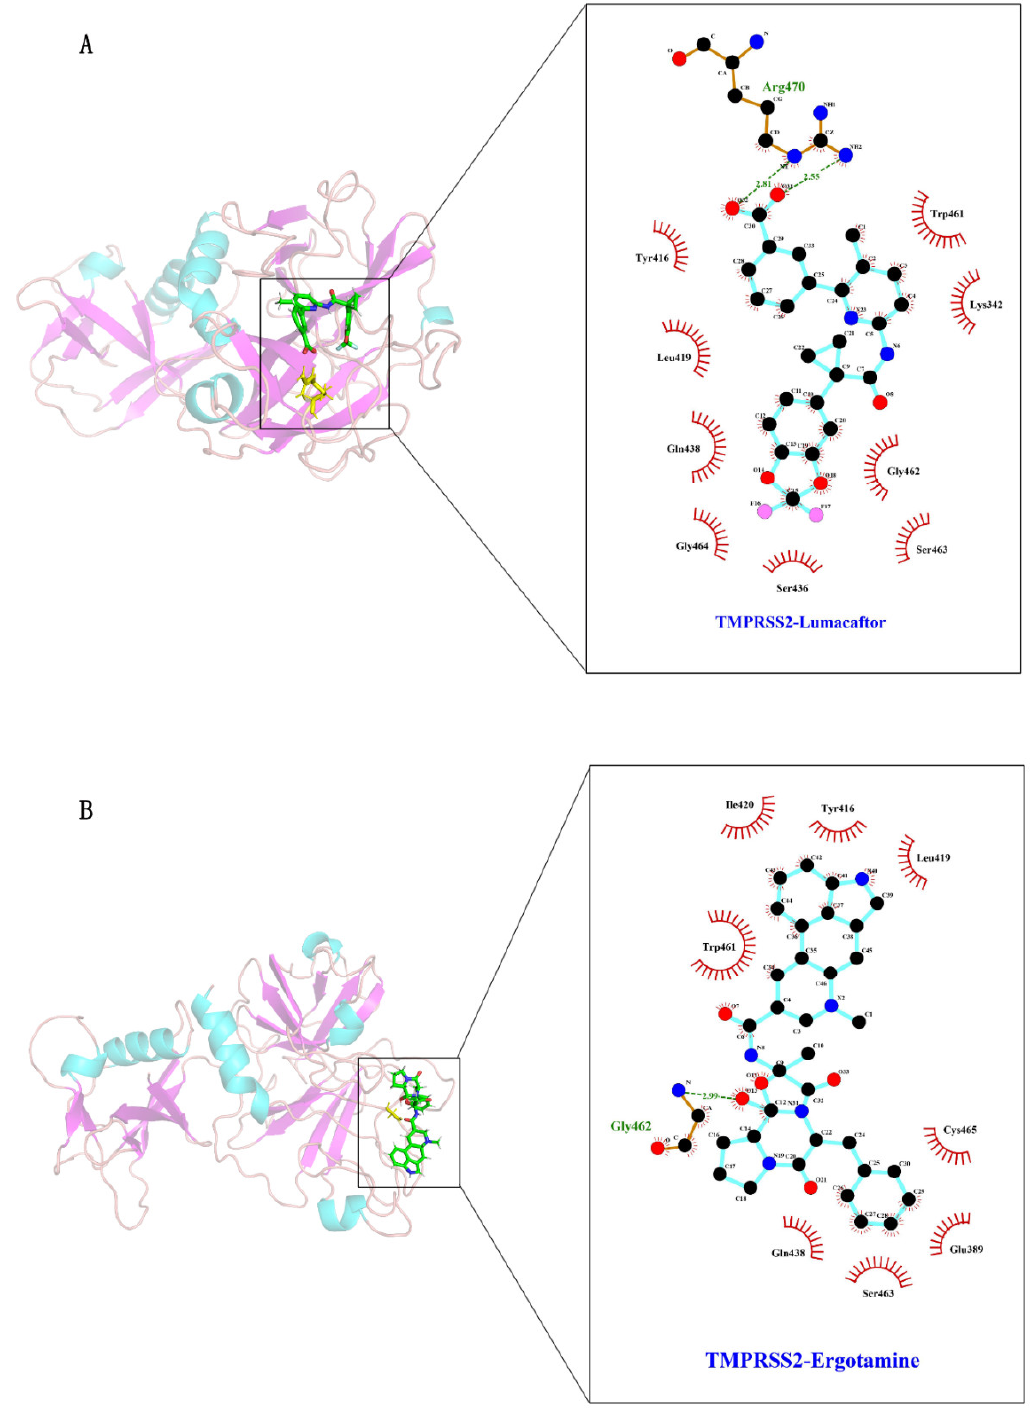
Figure 5. Interaction of amino acid residues around the active site of TMPRSS2 with inhibitors. Inhibitors lumacaftor ( A ) and ergotamine ( B ) are represented as green sticks. TMPRSS2 is represented by a cartoon structure. Amino acid residues hydrogen-bonded to inhibitors are shown as yellow sticks. Dotted green lines represent hydrogen bonds, and numbers indicate the distance between donor and acceptor atoms. Red circles represent hydrophobic